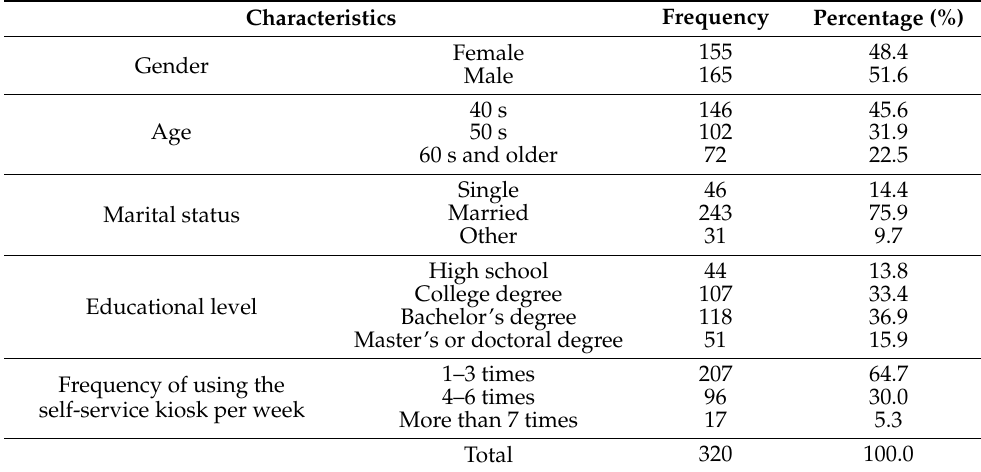
Table 1. Participant